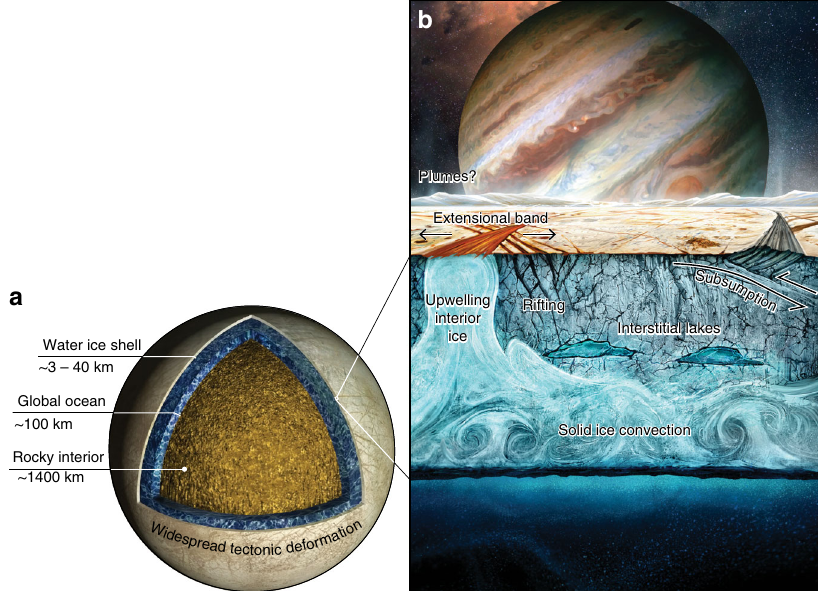
Fig. 1 Cutaway views of Europa ’ s water ice shell and saltwater ocean. We show the scale of ( a ) the individual layers in relation to each other, and ( b ) an artistic schematic (artist: Jeff Nentrup) of different tectonic and geodynamic processes that might be at play within the ice shell today or in the past. Each of these processes may play a unique role in de fi ning Europa ’ s